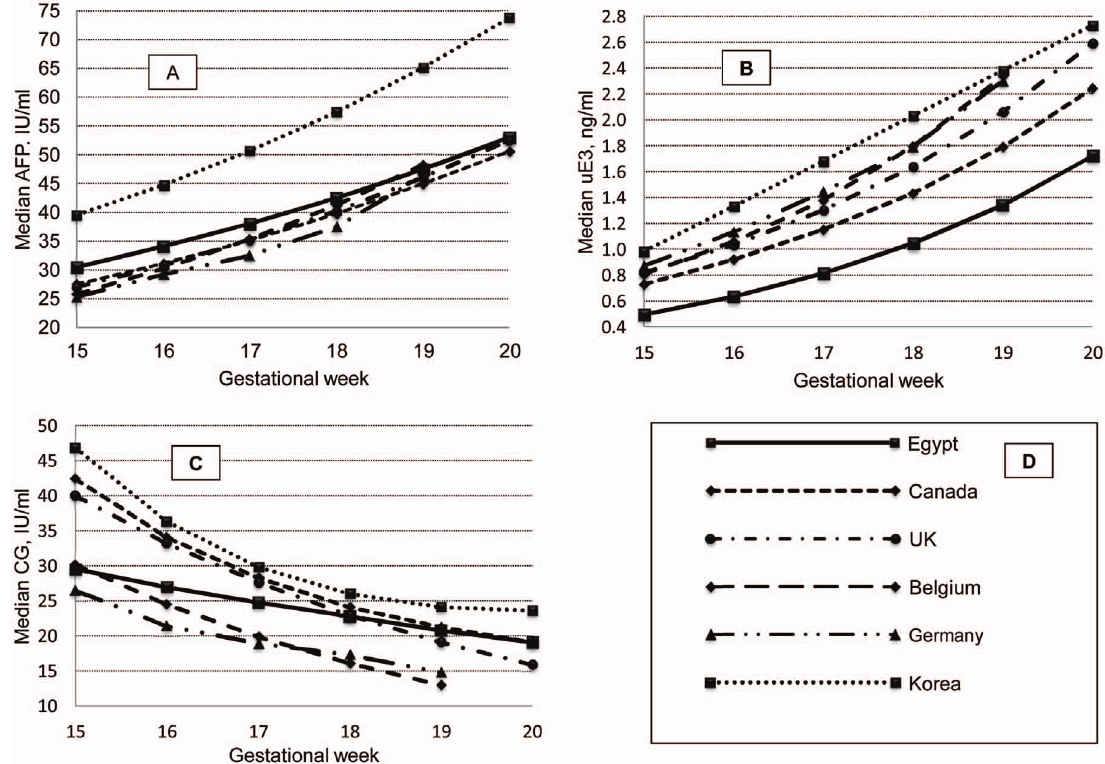
Figure 1. Comparison between median triple marker parameters in Egypt and different geographic regions. Panel A is AFP, B is uE3, C is CG and D is an explanatory legend. doi:10.1371/journal.pone.0110370.g001 PLOS ONE |